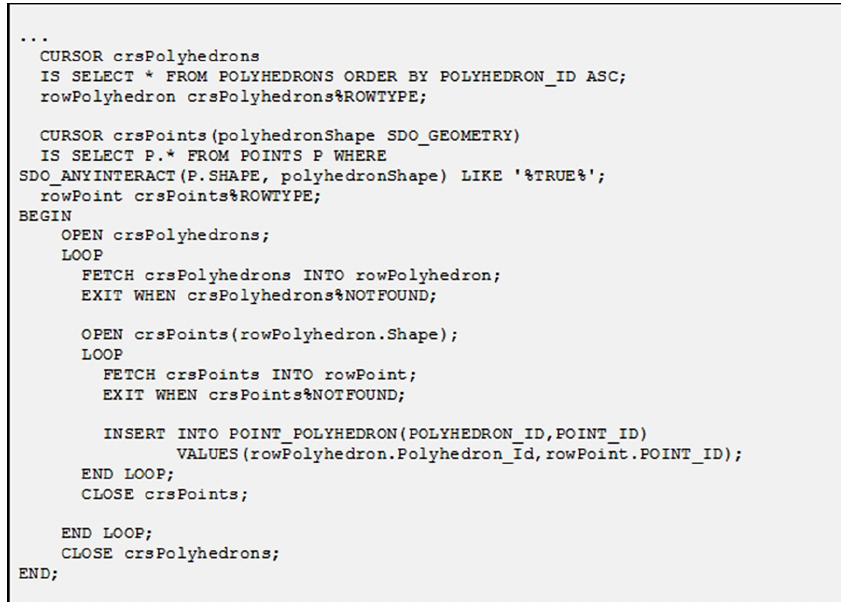
Figure 5. PL/SQL code block identifying the relationships between polyhedrons and points, then inserting to the